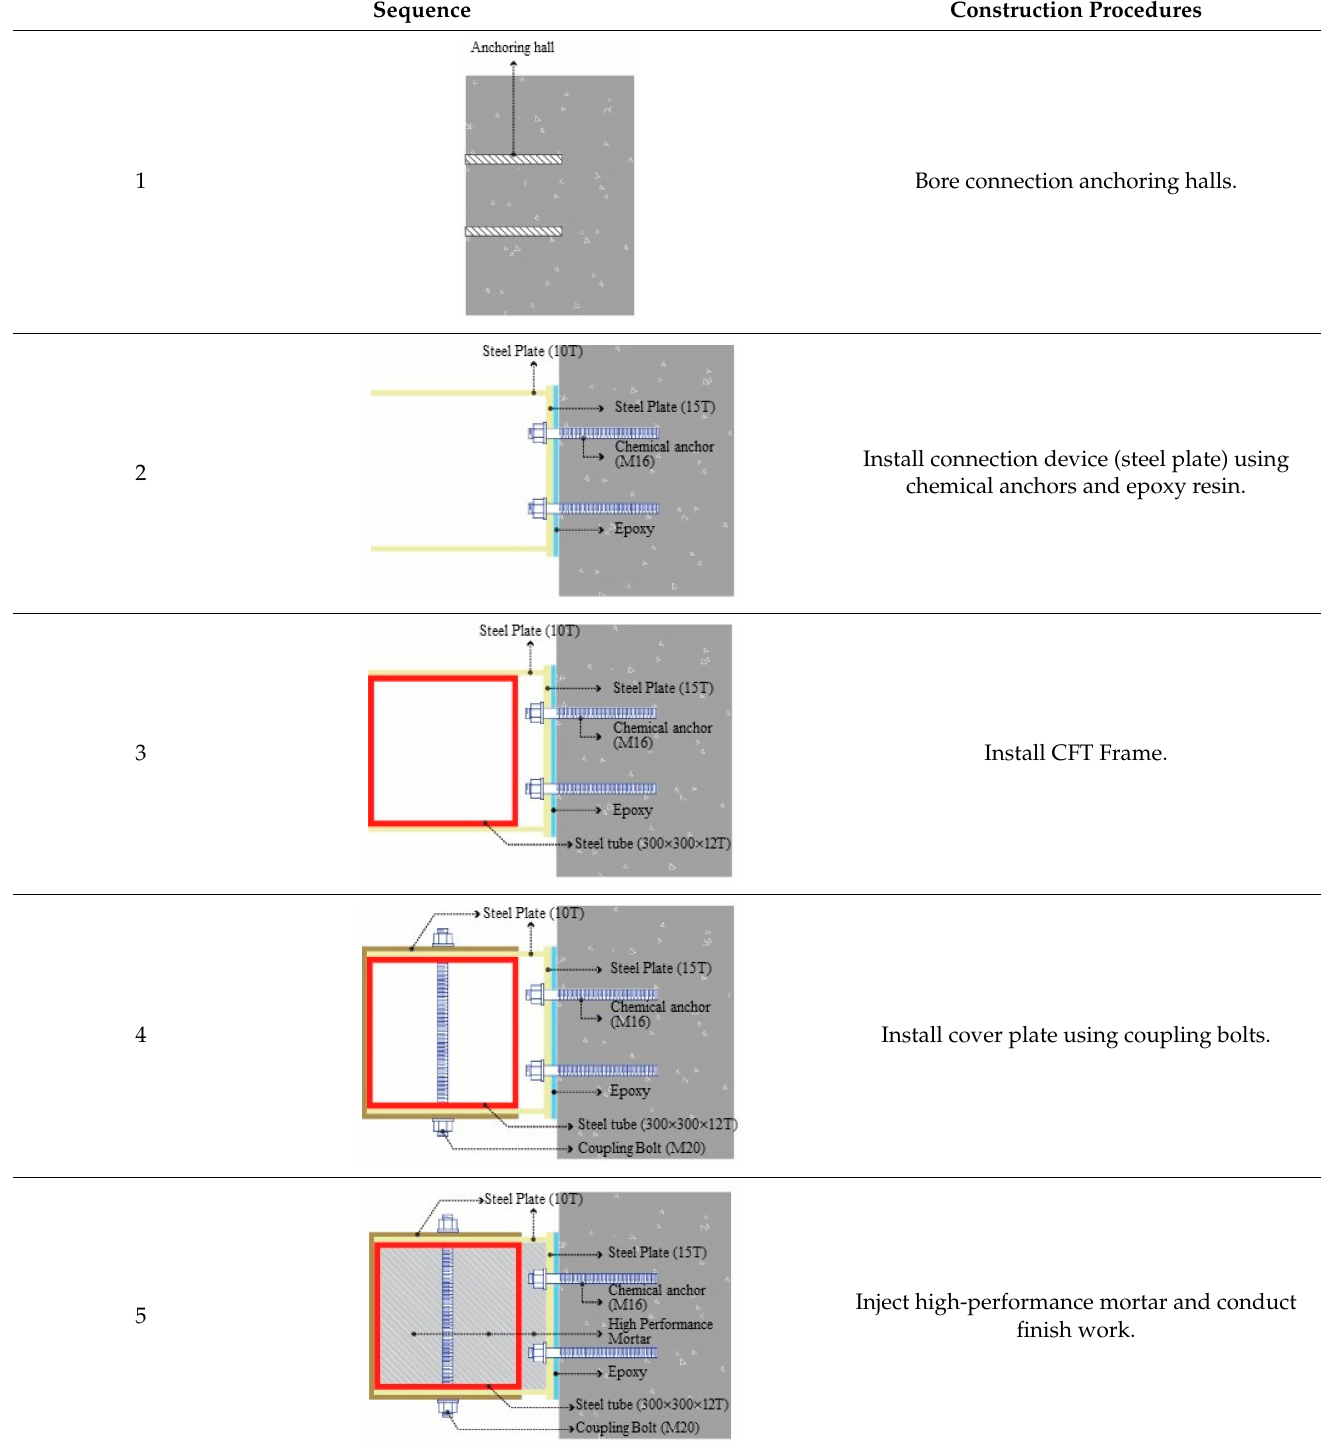
Table 1. Construction procedures for CFT-MF strengthening